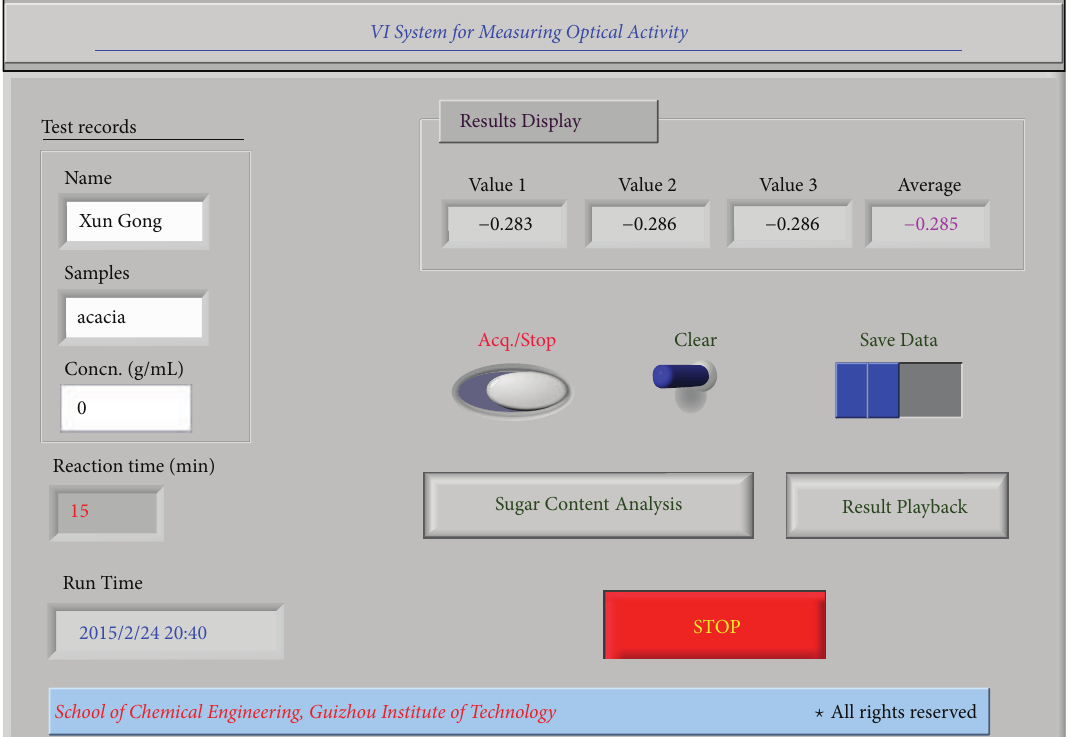
Figure 2: The main operation panel of the VI.